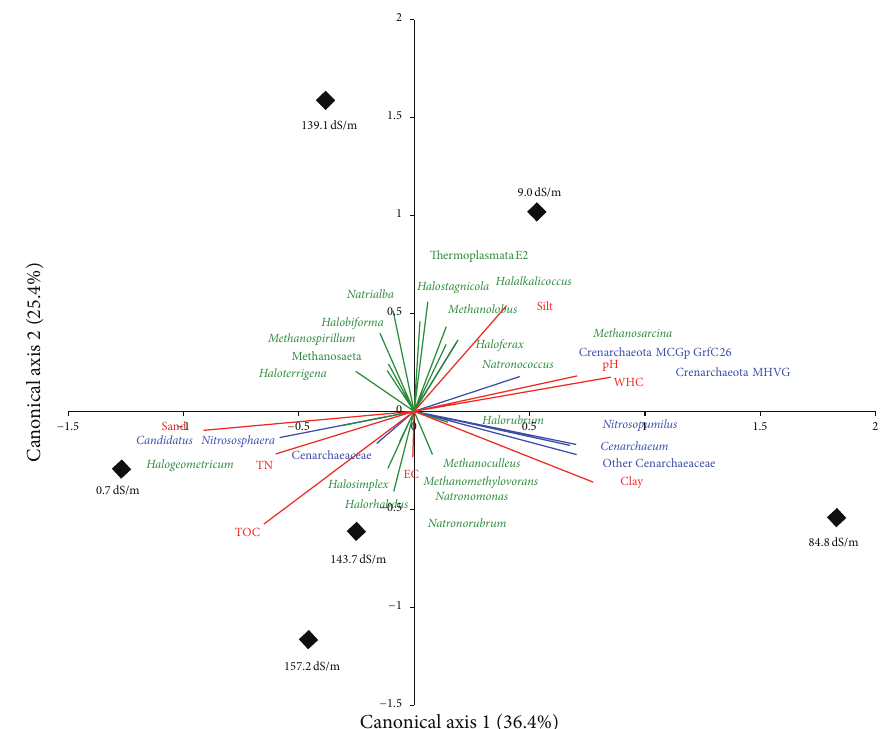
Figure 5: Canonical correlation analysis considering the percentages of the taxonomic groups and eight soil characteristics (particle size distribution (CLAY, SAND, and SILT), pH, electrolytic conductivity (EC), water holding capacity (WHC), total nitrogen (TN), and total organic carbon (TOC)) in alkaline-saline soils of the former lake Texcoco with different electrolytic conductivity and pH. Blue taxonomic groups are Crenarchaeota members; green taxonomic groups are Euryarchaeota